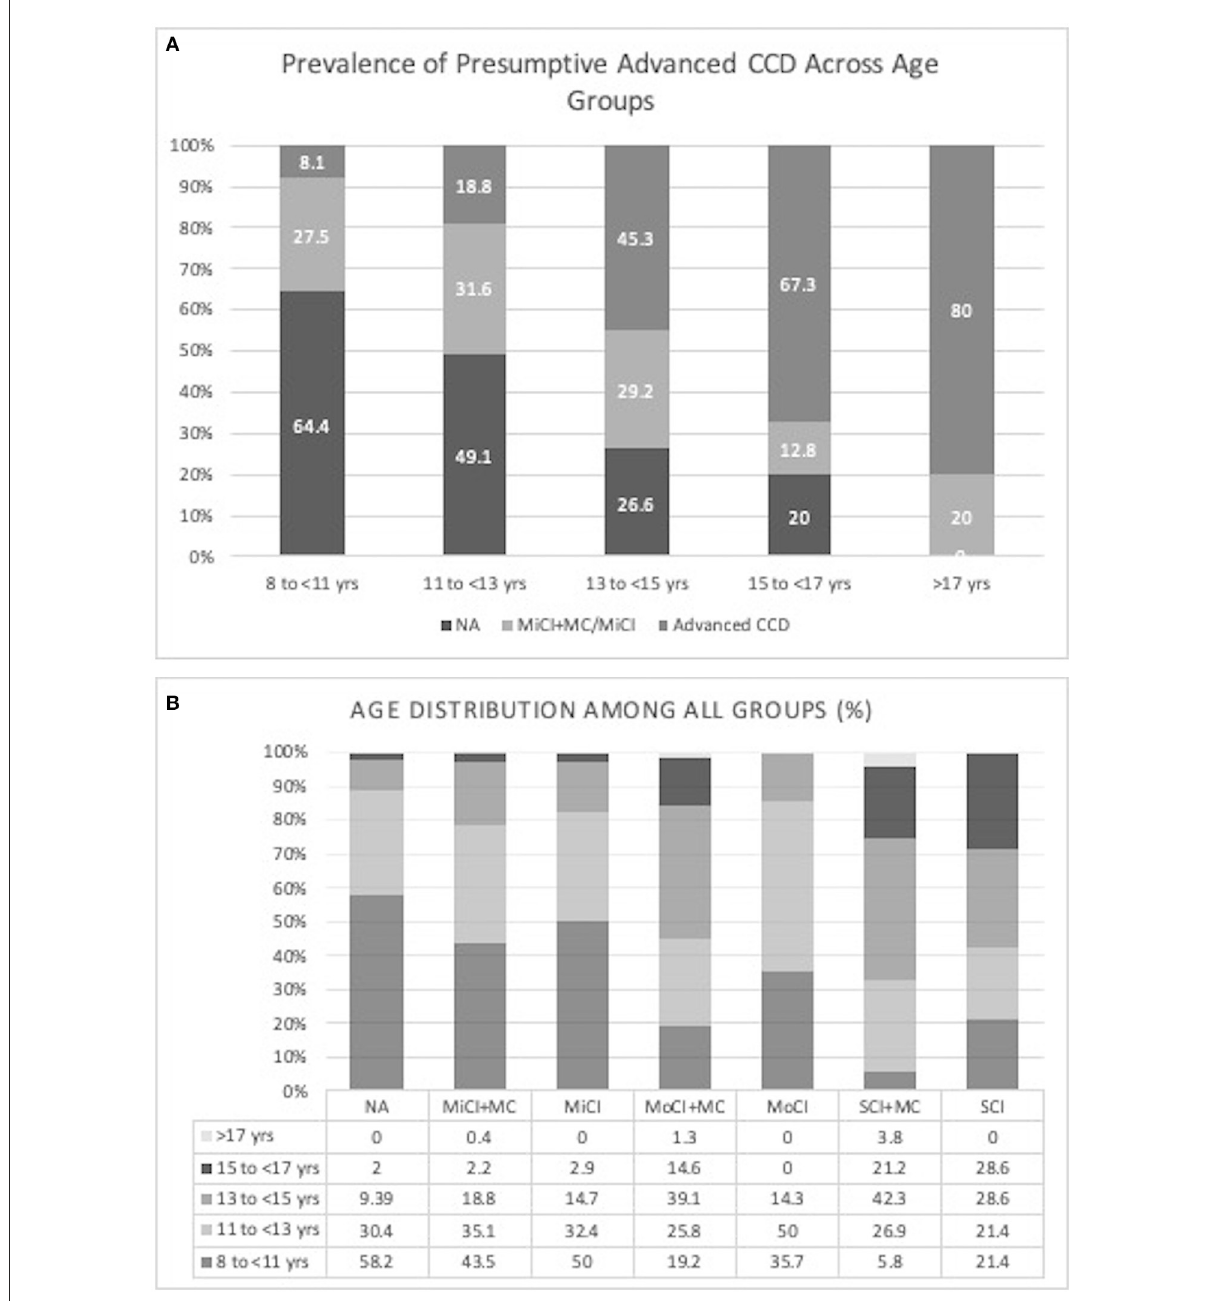
FIGURE1 (A) Prevalence of presumptive CCD across age groups (NA, Normal/Not affected; MiCI + MC, mild cognitive impairment with underlying medical conditions; MiCI, mild cognitive impairment without underlying medical conditions; Advanced CCD, moderate and severe cognitive impairment with and without underlying medical conditions), (B) Age distribution among all groups (%) (NA, Normal/Not affected; MiCI + MC, mild cognitive impairment with underlying medical conditions; MiCI, mild cognitive impairment without underlying medical conditions; MoCI + MC, moderate cognitive impairment with underlying medical conditions; MoCI, moderate cognitive impairment without underlying medical conditions; SCI + MC, severe cognitive impairment with underlying medical conditions; SCI, severe cognitive impairment without underlying medical conditions).